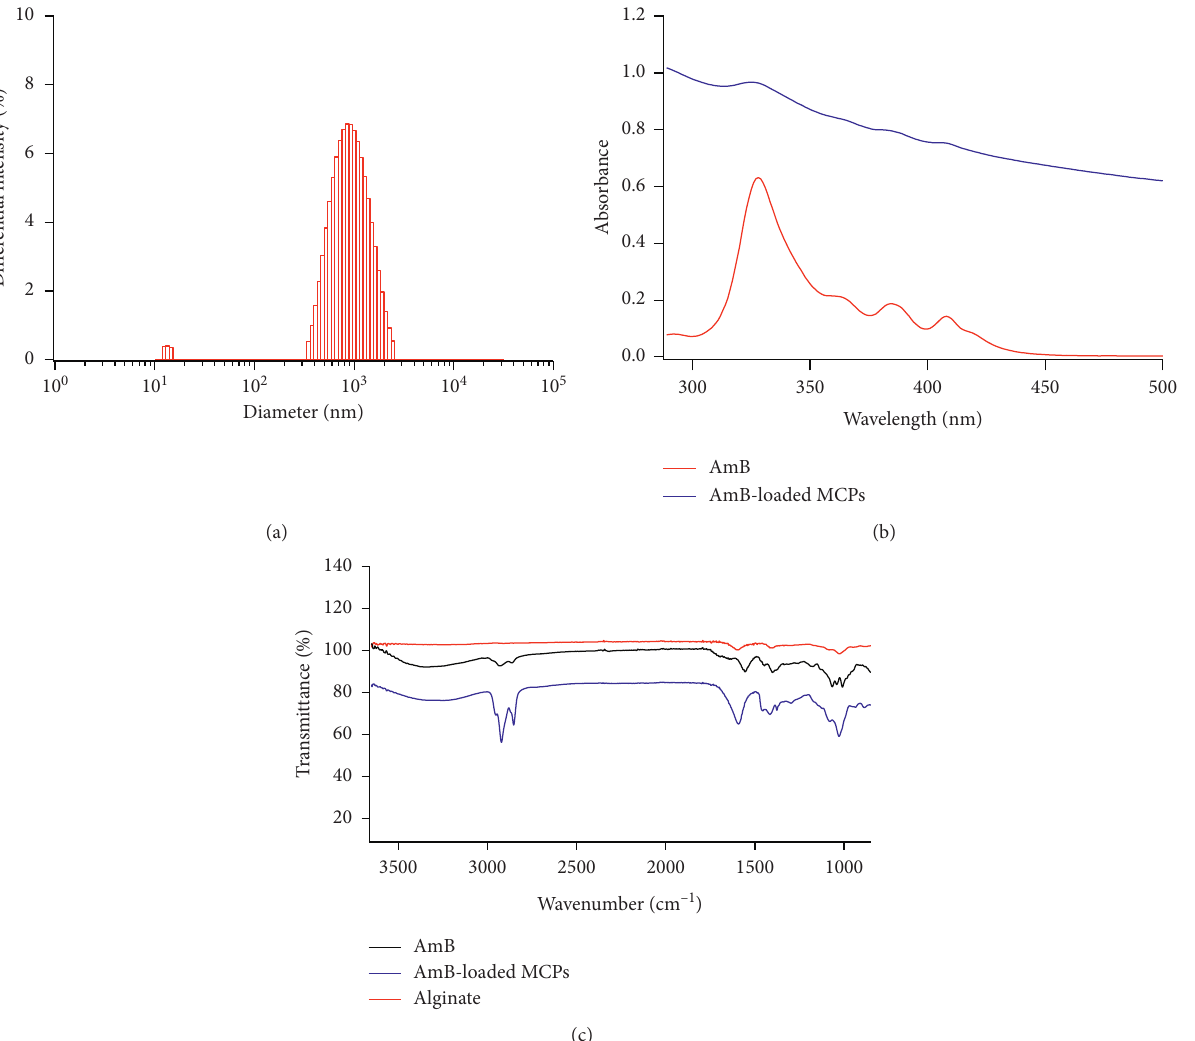
Figure 2: AmB-loaded MCPs characterization. (a) Hydrodynamic diameter of AmB-loaded MCPs. (b) Absorption spectra of MCPs-AmB and free AmB. (c) FTIR spectra of AmB-loaded MCPs, free AmB, and